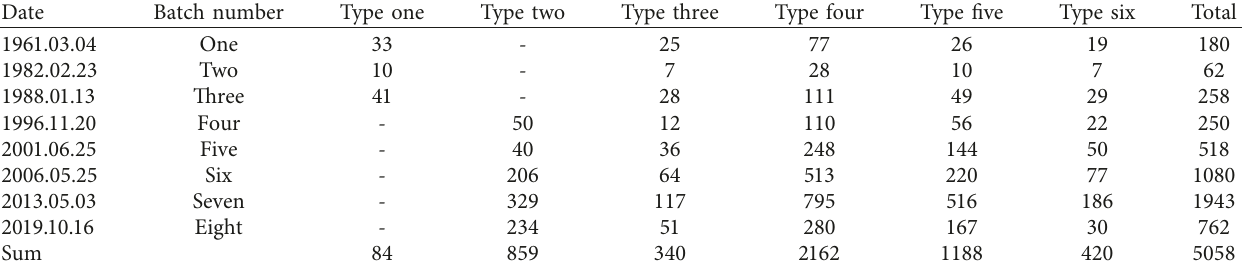
Table 1: Key national preservation units of cultural relics.